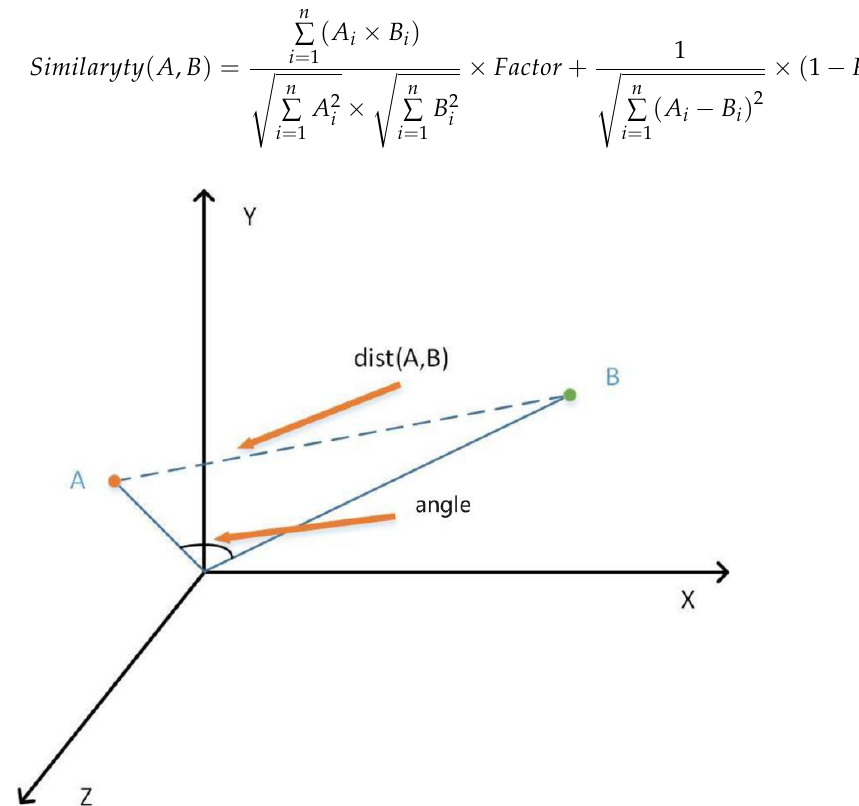
Figure 3. Schematic explanation of the CES module(dist means to calculate the Euclidean distance between vectors A and B; angle means the angle between the two vectors). between vectors A and B ; angle means the angle between the two